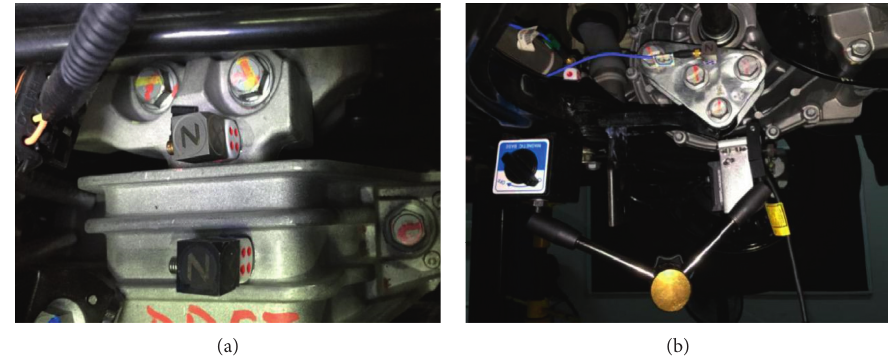
Figure 4: Mount acceleration and deformation measurement. (a) Right mount vibration acceleration test. (b) Torque strut vibration acceleration test.